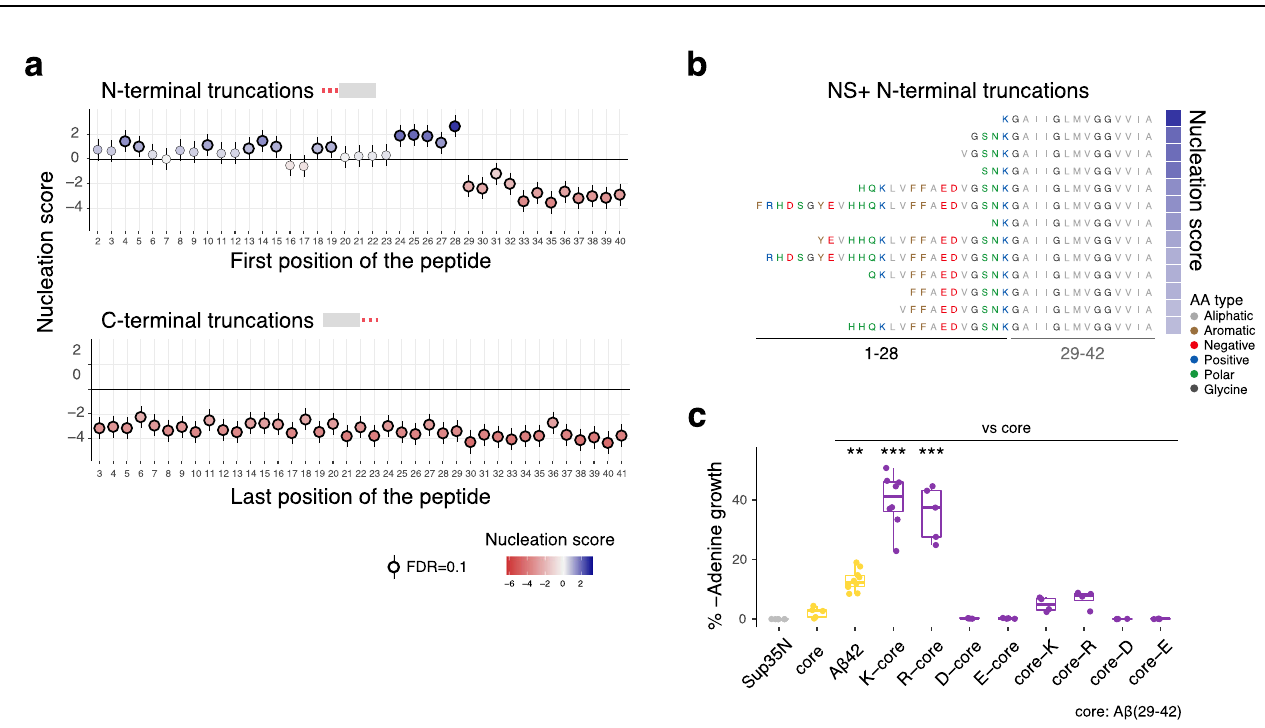
( n >=4 biological replicates/variant). Boxplots represent median values and the lower and upper hinges correspond to the 25th and 75th percentiles, respectively. Whiskers extend from the hinge to the largest value no further than 1.5*inter- quartile range. One-way ANOVA with Dunnett ’ s multiple comparisons